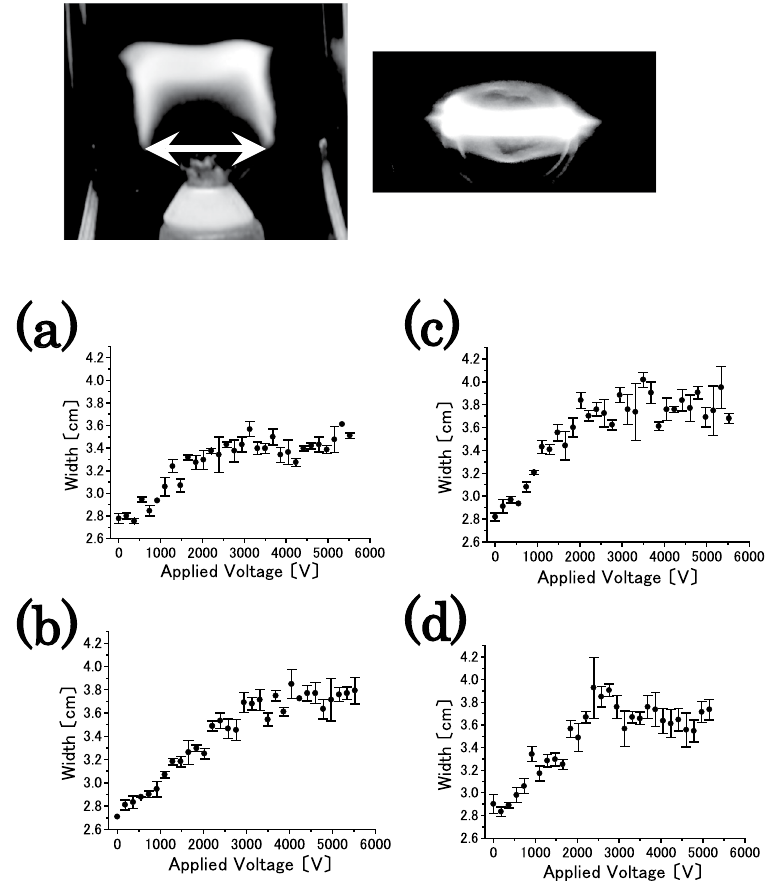
Figure 2. Change in the shape of the flame that occurs is shown when a strong ac electric field is applied. In upper trace, the photographs are obtained from the horizontal (left trace) and top (right trace) directions. In lower trace, relationship between the applied amount of ac voltage as rectangular voltage pulse and the width of the inner flame is shown. ( a ) 100 Hz, ( b ) 200 Hz, ( c ) 300 Hz, and ( d ) 400 Hz are